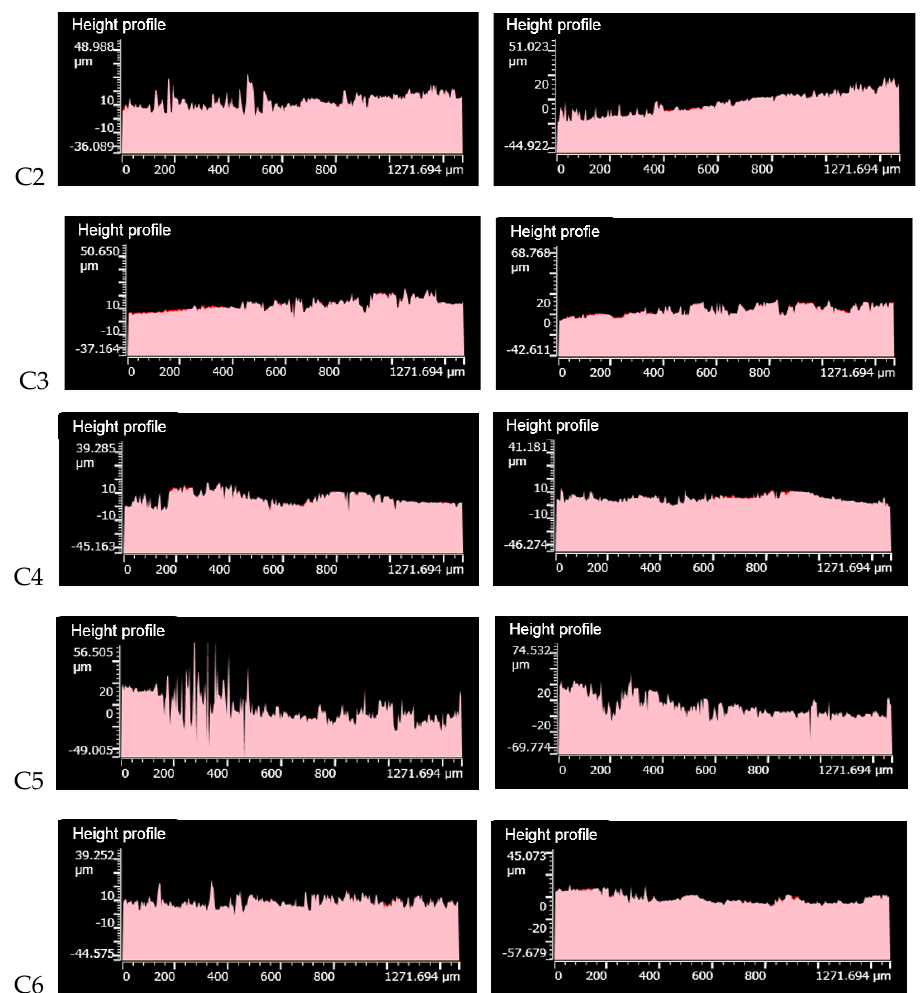
Figure 10. The average coefficient of friction of GF/rubber composites with different ratios against metal.